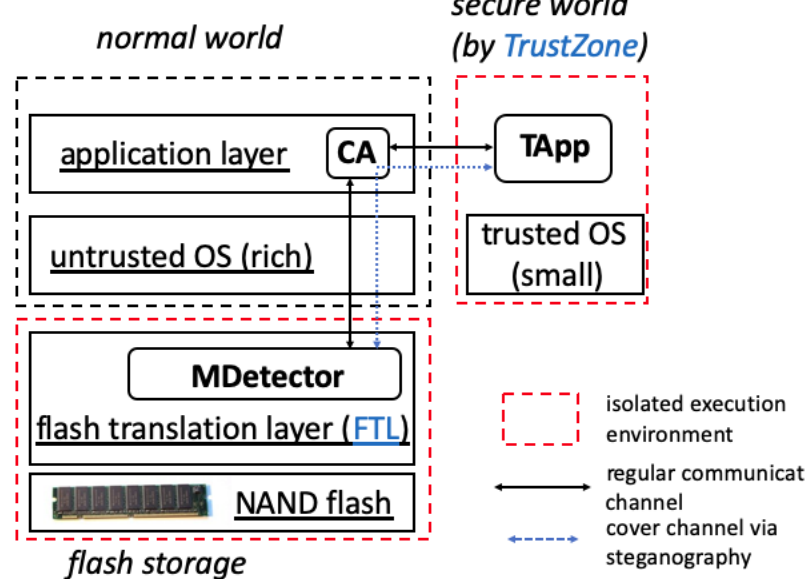
Figure 4. The design overview of our malware